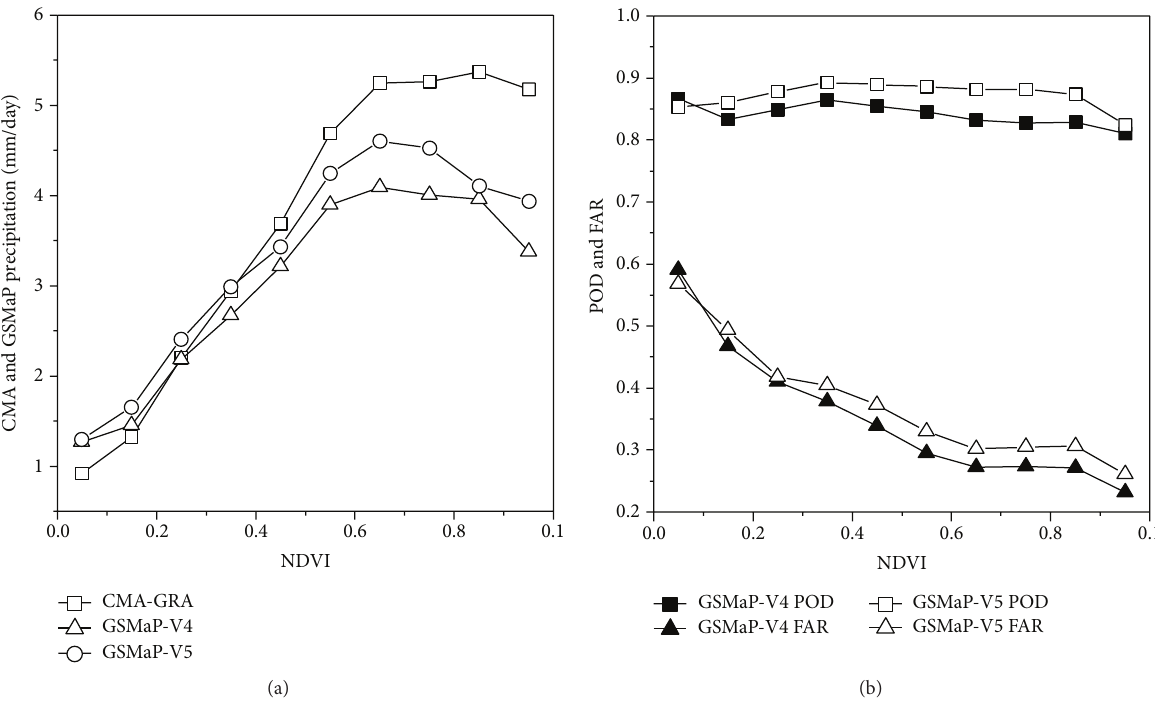
Figure 10: Relationship between statistics of GSMaP and NDVI. (a) CMA and GSMaP precipitation amount. (b) POD and